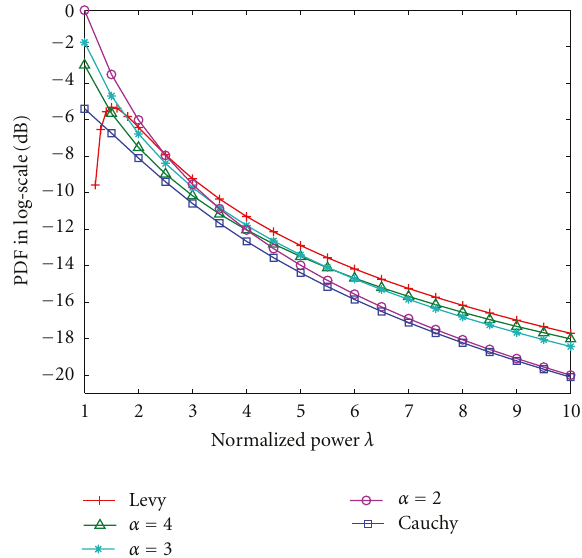
Figure 2: The PDFs of Cauchy and L´evy distribution, as well as the practical PDFs of the normalized interference power λ when α = 2, 3, and